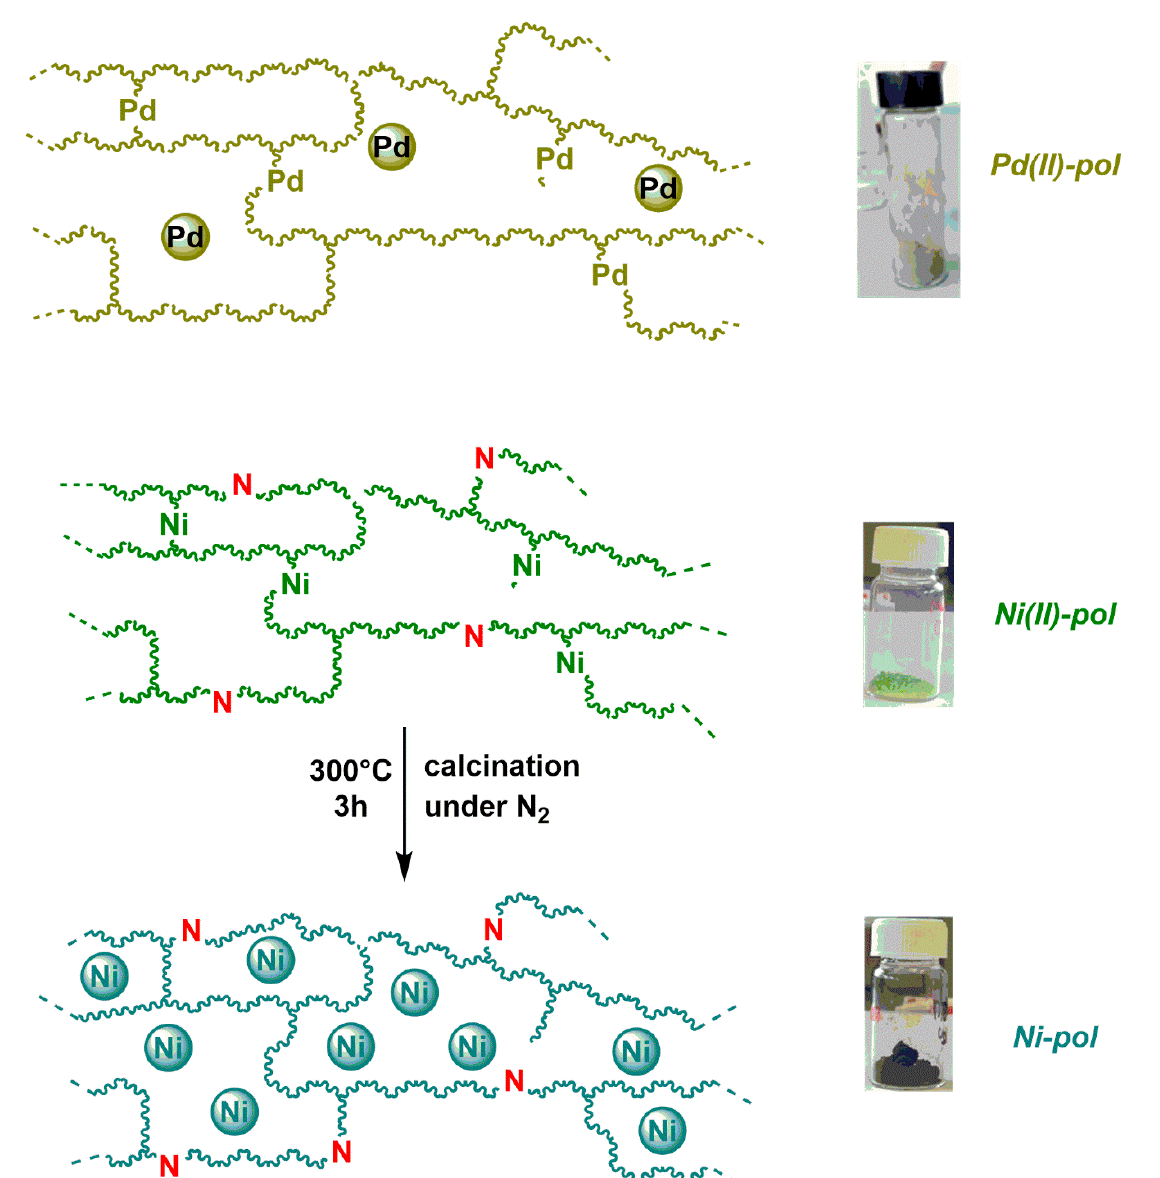
Figure 1. Schematization of Pd(II)-pol , Ni(II)-pol , and Ni-pol